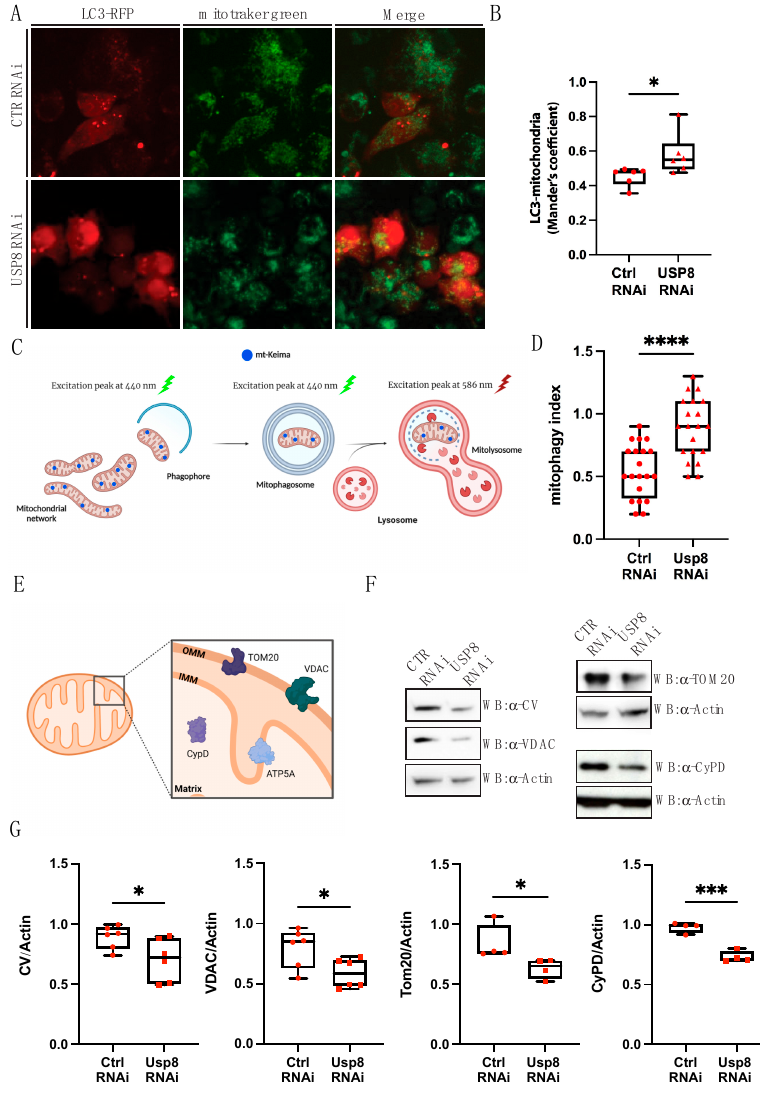
Figure 3. ( A ) Representative confocal images of cells transfected with LC3–RFP and loaded with MitoTracker Green ® to study mitochondria–autophagosome co-localization. Cells were treated with the indicated dsRNA (CTR and USP8), and after 24 h they were transfected with LC3–RFP for two days. After transfection, cells were loaded with MitoTracker Green ® and imaged with a spin- ning disk confocal microscope, using a UPlanSApo 60×/1.35 NA objective (iMIC Adromeda, TILL Photonics). ( B ) Quanti fi cation of ( A ). Autophagosome–mitochondria interaction was evaluated by measuring the percentage of LC3 that co-localizes with mitochondria by Mander’s coe ffi cient of co-localization using ImageJ JACoP (“Just Another Colocalization Plug in”), following 3D volume rendered reconstruction of 40 z -axis images, separated by 0.2 µm. Chart shows mean ± SEM of n = 3